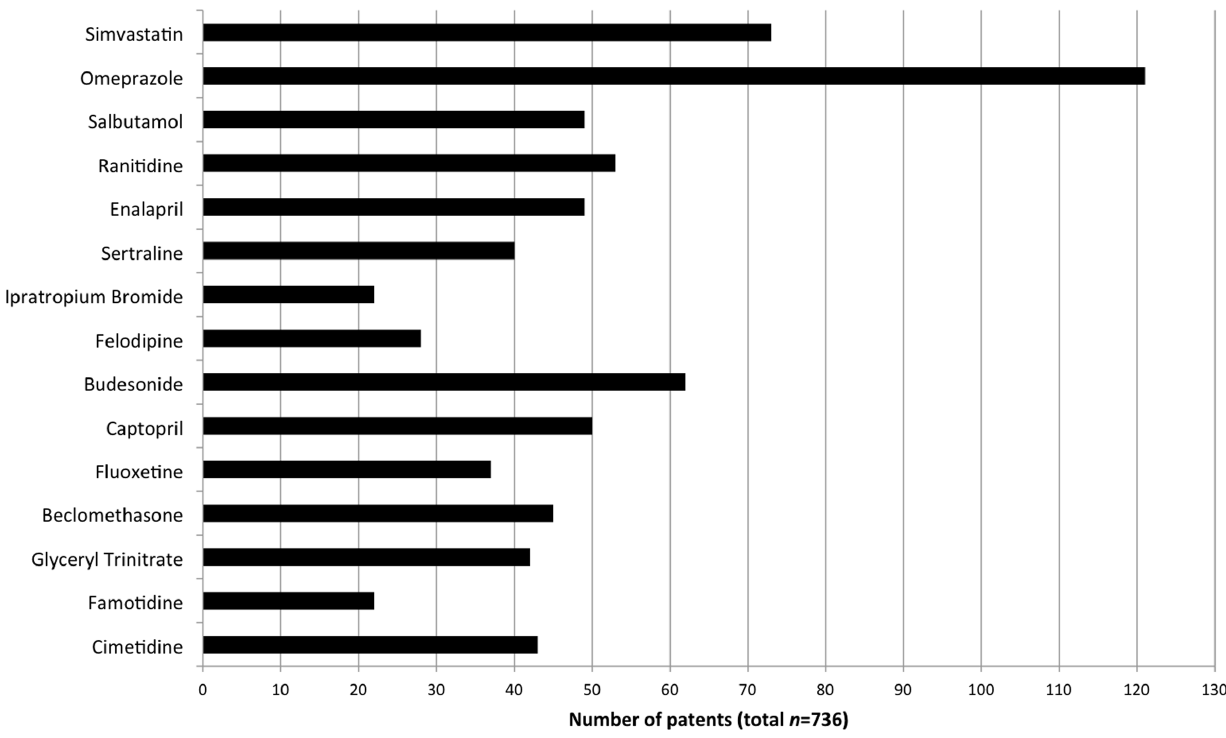
Figure 2. Patent counts by high-cost drug. This bar chart shows the count of patents associated with each high-cost drug in our sample. The drugs are arranged in descending order of total cumulative cost in the period 1991–2008.